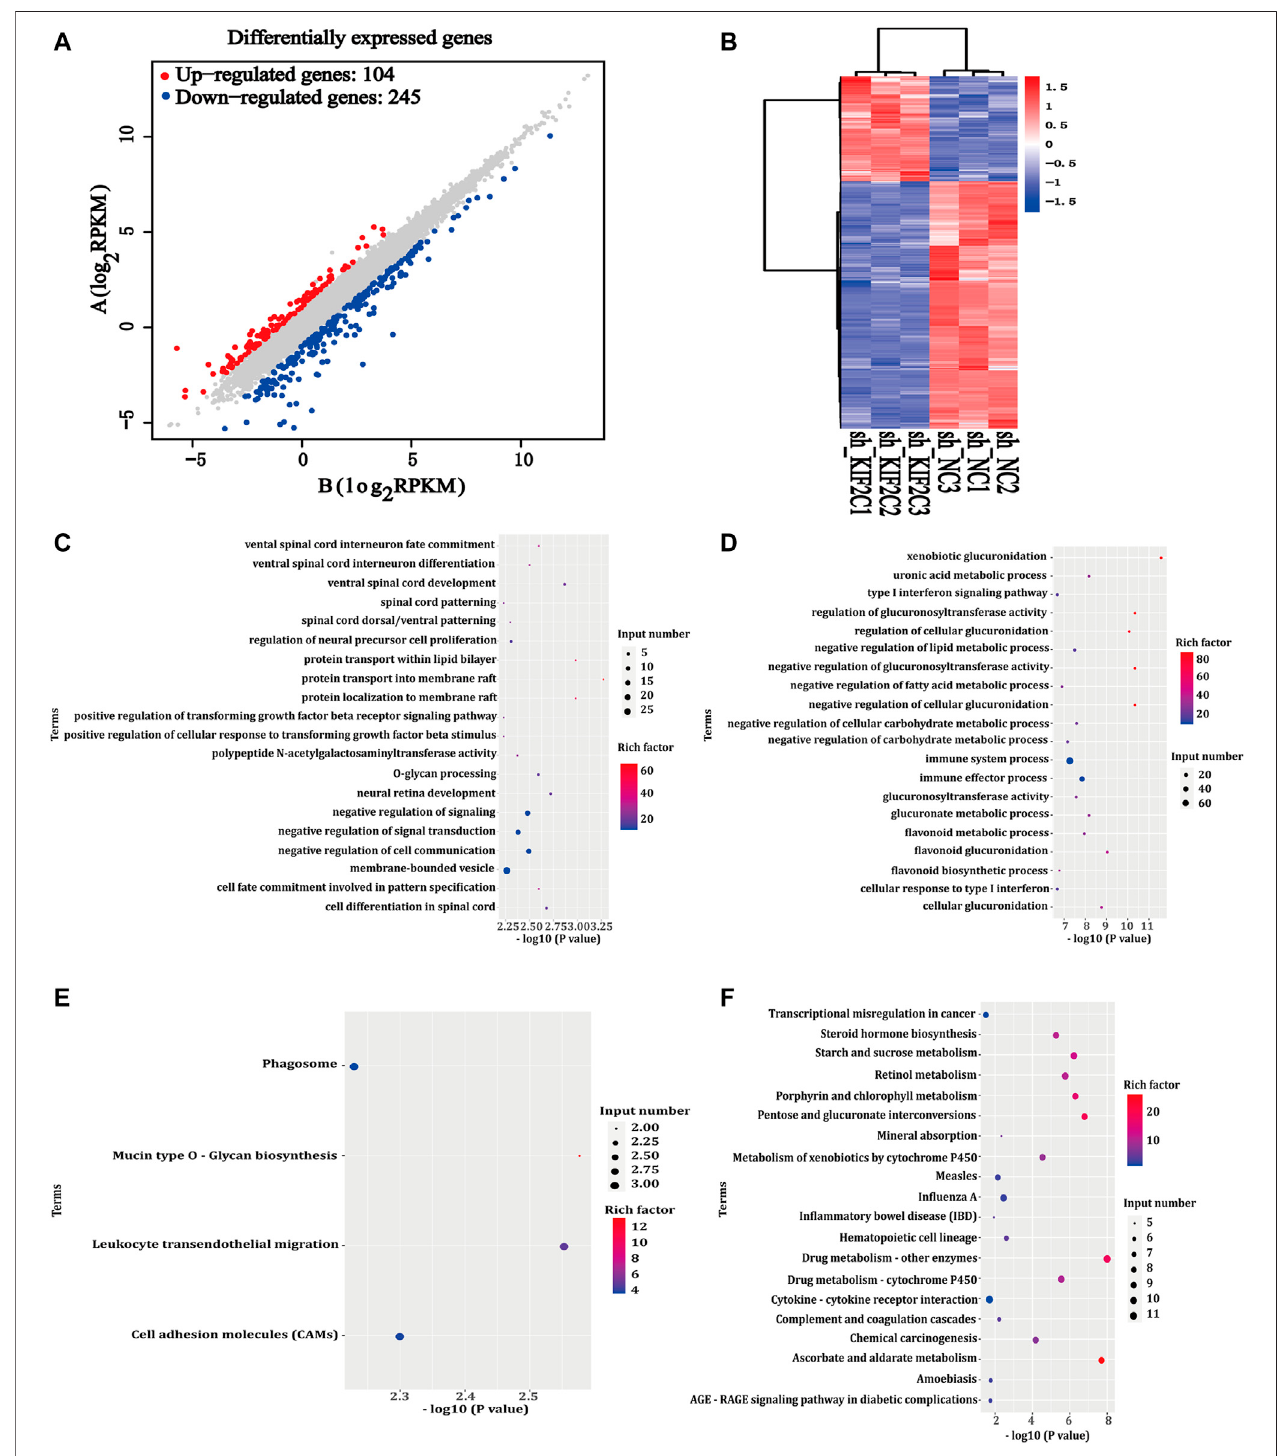
FIGURE 9 | Differentially expressed genes of KIF2C . (A) Scatter plot of differentially expressed genes between comparison groups; gray dots represent not differentially expressed genes, blue dots represent differentially downregulated genes, and red dots represent differentially upregulated genes; (B) leftmost image is overallhierarchicalclusteringdiagramofalldifferentiallyexpressedgenesinallcomparisongroups,clusteredbyreadsperkilobaseoftranscriptpermillionreadsmapped value, red represents high-expressed genes, and blue represents low-expressed genes. x-axis represents different samples, and y-axis represents gene names; (C,D) GO enrichment map of upregulated/downregulated genes; (E,F) KEGG enrichment map of upregulated/downregulated genes.